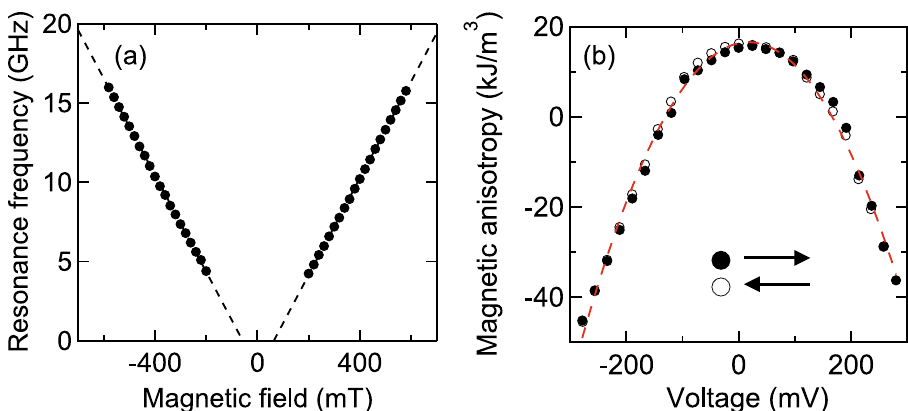
Fig. 6 Characterization of HCMA from FMR measurement. a Perpendicular magnetic fi eld dependence of the ferromagnetic resonance frequency measured by the spin-torque diode technique. The dashed lines indicate linear fi tting. b Bias-voltage dependence of perpendicular magnetic anisotropy. The open and fi lled circles represent the voltage sweep directions. The dashed red line is the fi tting curve of a